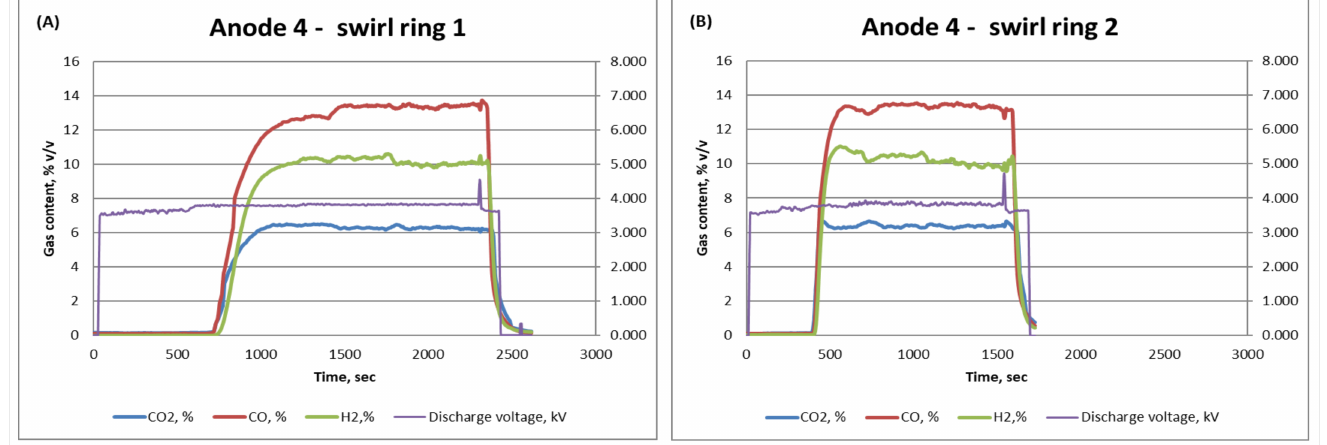
Figure 12. Comparison between Rings 1 ( A ) and 2 ( B ) with Anode